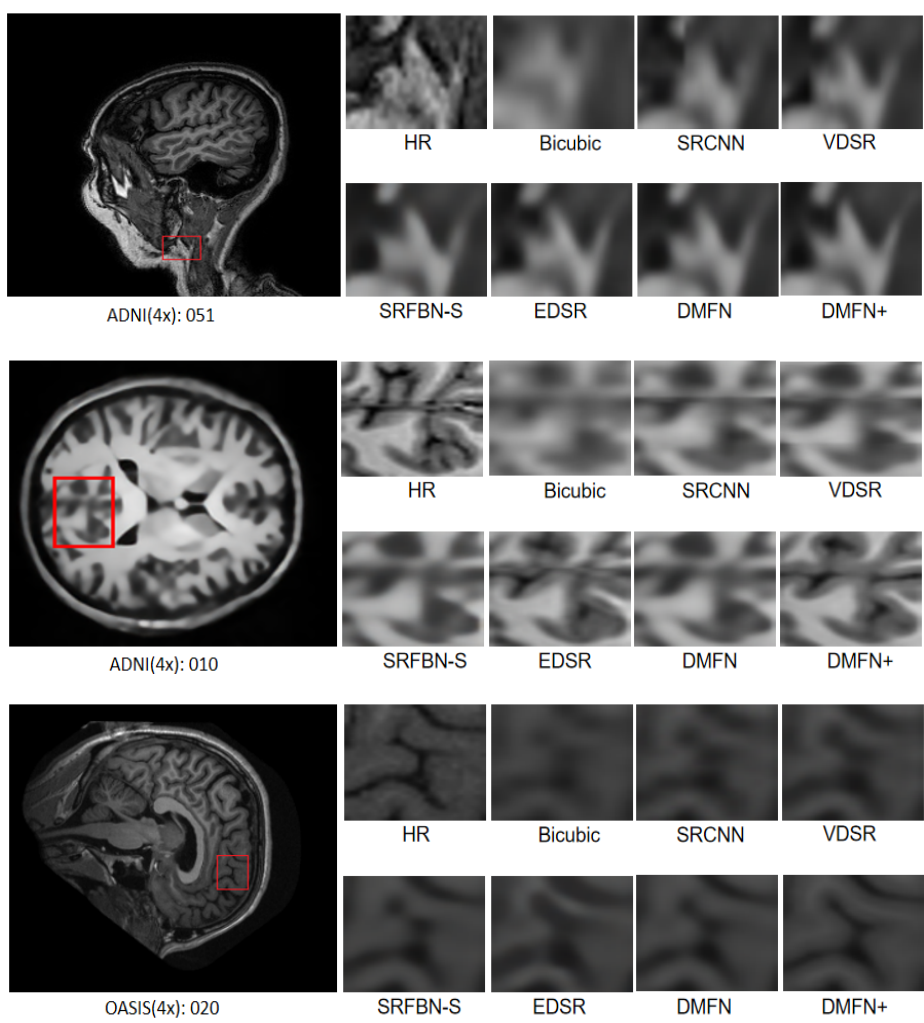
Figure 10. Comparison of visualization results on ADNI100 [36] and OASIS100 [37] datasets. Images on the right are the recovery details of the red